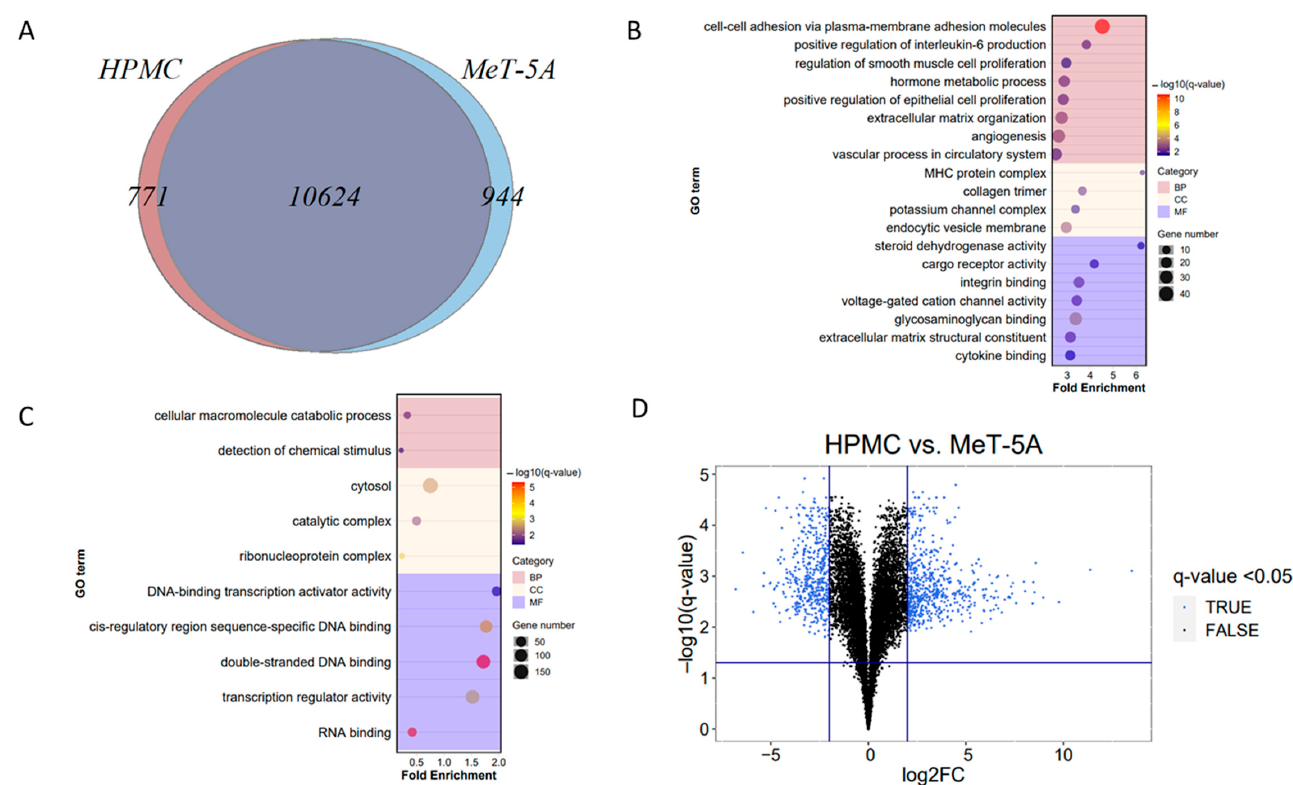
Figure 2. Mesothelial cell model comparisons ( A ) Venn diagram of differentially expressed genes in human primary peritoneal mesothelial cells (HPMC) versus immortalized pleural mesothelial cell line (MeT-5A). ( B ) Gene Ontology (GO) term enrichment analysis of 771 HPMC-specific genes. Number of genes per GO term and fold enrichment are given by bubble size and on the x -axis, respectively. The pink categories represent significantly regulated biological processes (BP), the light-yellow categories cellular components (CC), the purple categories blue molecular function (MF), as identified by Panther Gene Ontology Enrichment Analysis (FDR Q-value < 0.05). ( C ) 944 MeT-5A-specific genes ( D ) Volcano plot of differentially regulated transcripts in HPMC vs. MeT-5A (FDR Q-value < 0.05, abs(log2FC) > 2), 488 genes were less and 612 were more abundant in HPMC.